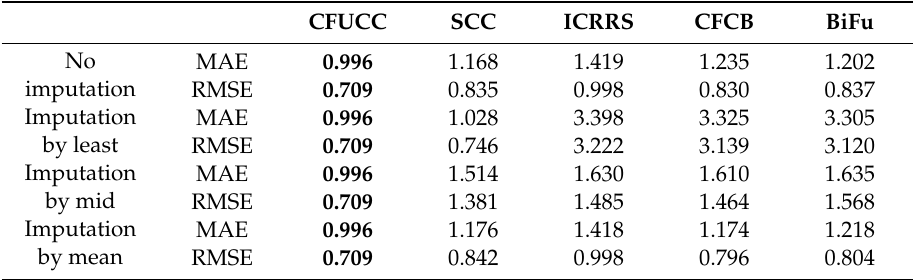
Table 7. Impact of imputation on performance for di ff erent methods.